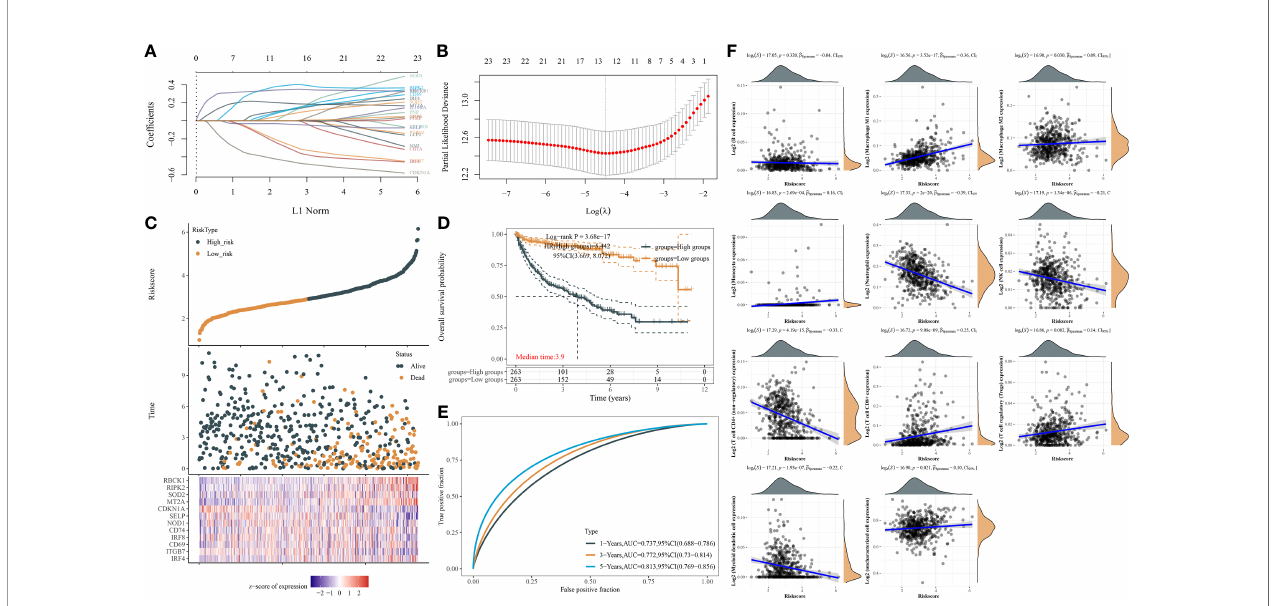
FIGURE 3 | IFN- g response signature prediction models (IPMs) predicting progression-free survival (PFS) and immune cell in fi ltration of ccRCC. (A) Coef fi cients of the 24 IFN- g response signatures are displayed by the lambda parameter. (B) Partial likelihood deviance versus log ( l ) was drawn using LASSO Cox regression model. (C) The dotted line represented the median risk score and divided the patients into low-risk and high-risk groups. (D) Risk score of the 24 IPMs for predicting PFS of ccRCC patients from TCGA was displayed using Kaplan – Meier curves. p -values and hazard ratio (HR) with 95% con fi dence interval (CI) were generated by log-rank tests and univariate Cox proportional hazards regression. (E) Time-dependent ROC analysis of the IPMs was generated in predicting 1-, 3-, and 5-year progression status. (F) Spearman correlation analysis of IPMs and immune cell in fi ltration. The horizontal axis in the fi gure represents the expression distribution of risk score of IPMs, and the ordinate is the expression abundance of immune cell in fi